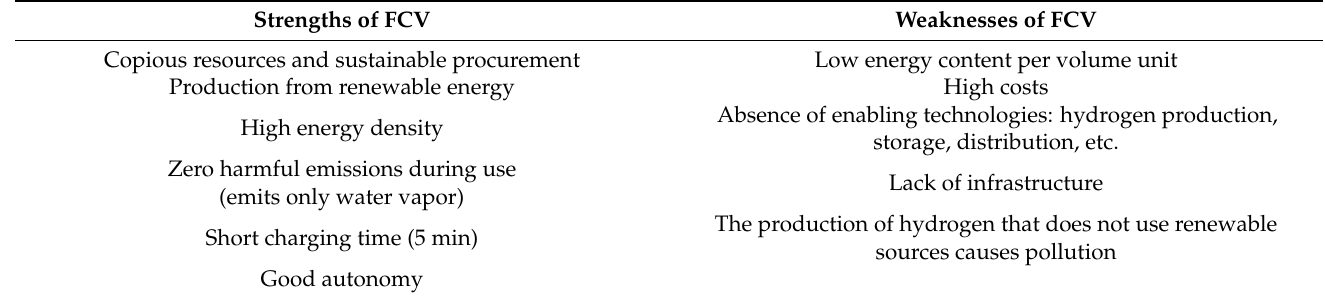
Table 6. The strengths and weaknesses of FCV/hydrogen